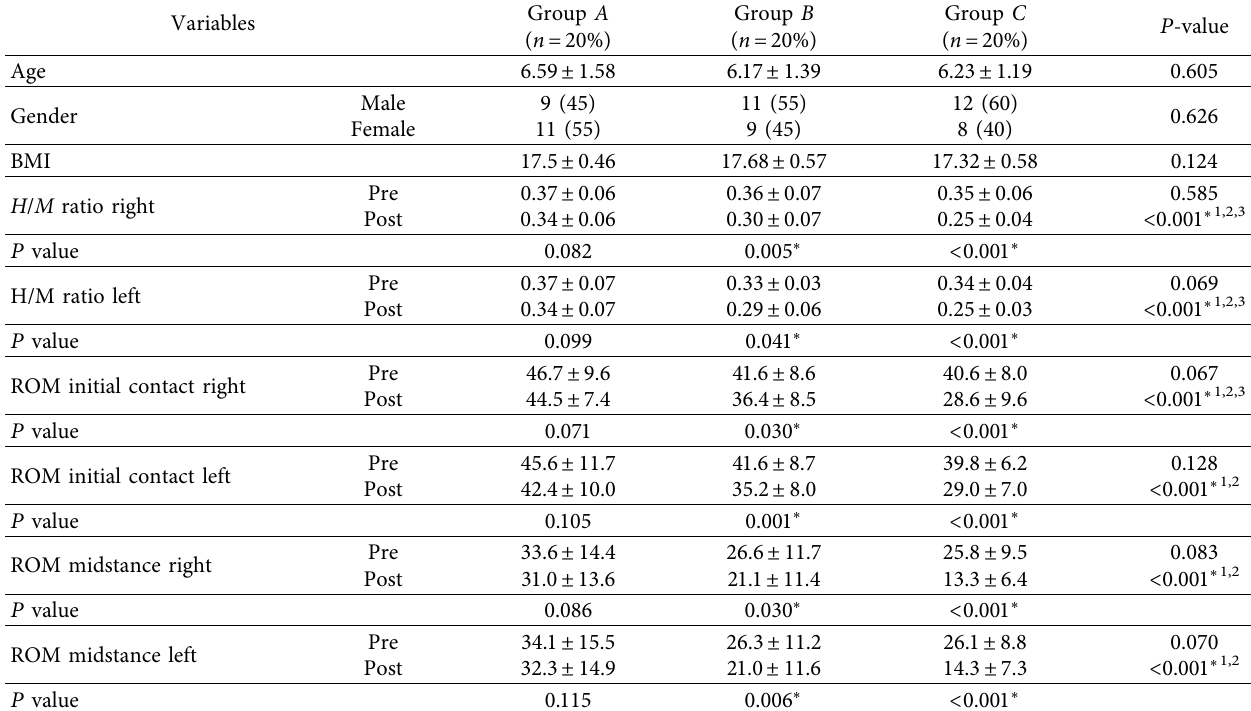
Table 1: Comparison of H/M ratio, ROM at initial contact and at midstance pre- and post-therapy in both right and left knees between the studied groups and within each